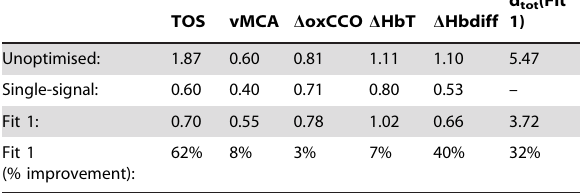
Table 2. The (weighted) signal-to-data distances for each of the five measured signals, and the sum of these distances, averaged across all thirty challenges for Fit 1.